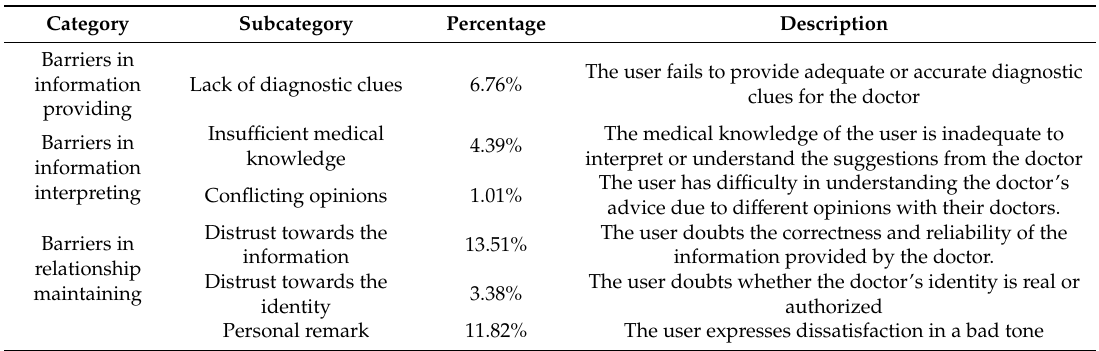
Table 3. Antecedents of poor DPR from the doctors’